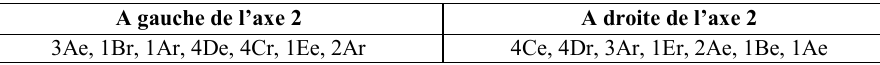
Tableau 6. Positionnements des modalités sur l’axe